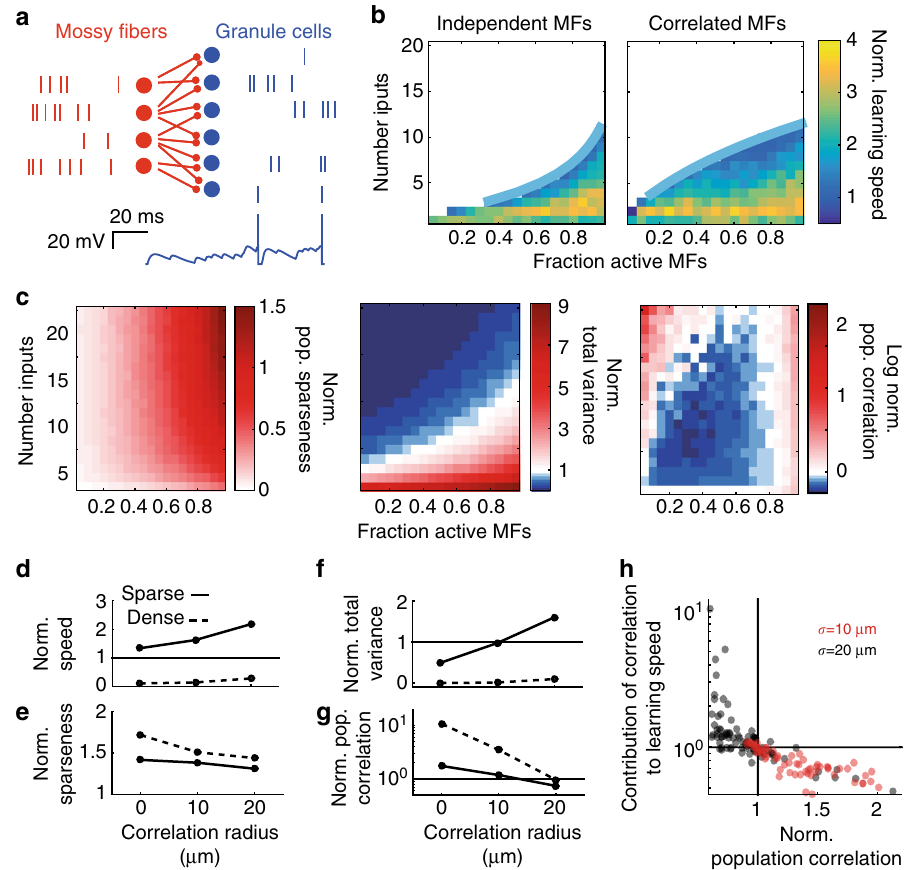
Fig. 6 Pattern separation and learning speed depend on synaptic connectivity in biologically detailed spiking models of the cerebellar input layer. a Top: Schematic of biologically detailed spiking network model with sample spike trains. Bottom: example voltage trace from a granule cell (GC) in network. b Normalized learning speed for a spiking network with independent (left) and correlated (right, σ = 20 μ m) mossy fi ber (MF) activity patterns. c Normalized population sparseness (left), normalized total variance (center), and log normalized population correlation (right) for networks with different numbers of synaptic connections receiving correlated MF activity patterns ( σ = 20 μ m). d Median normalized learning speed plotted against correlation radius for sparse (solid, N syn = 4) and dense (dashed, N syn = 16) synaptic connectivities. e - g Same as d for normalized population sparseness e , normalized total variance f , and normalized population correlation g . h Change in learning speed due to correlations (i.e., GC speed/speed for shuf fl ed GC spike trains) plotted against the normalized population correlation. Each point represents different values of N syn and f MF . Correlation radii were σ = 10 μ m (red) or 20 μ m